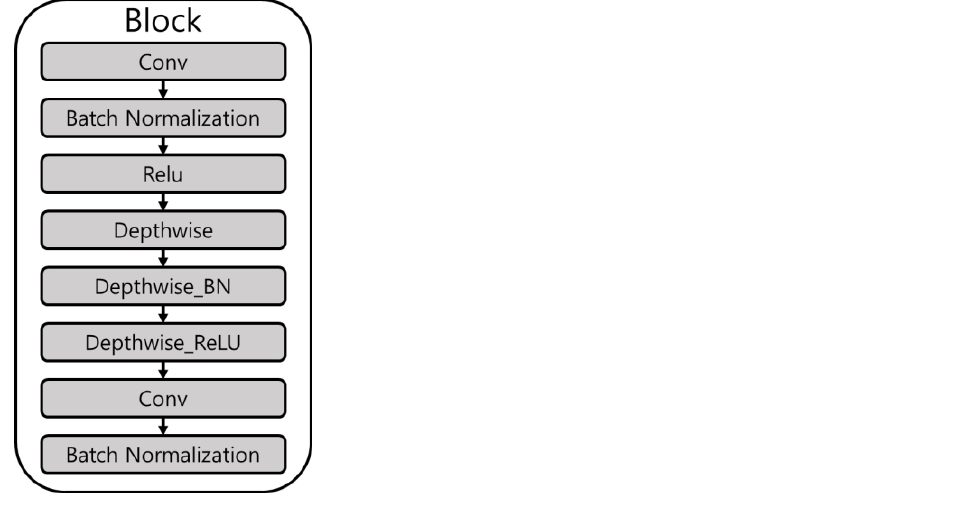
the input data. Normalization is performed in blocks so that algorithms can process data. MobileNetv2 has 16 interconnected blocks.